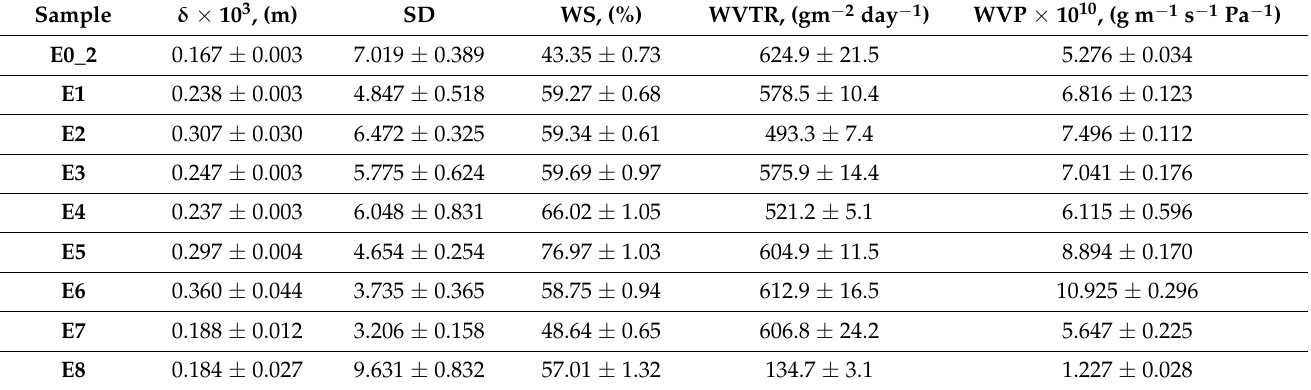
Table 7. Film thickness (m), swelling degree, water solubility (%), water vapor transmission rate (g m − 2 day − 1 ), and water vapor permeability of the composite films (g m − 1 s − 1 Pa − 1